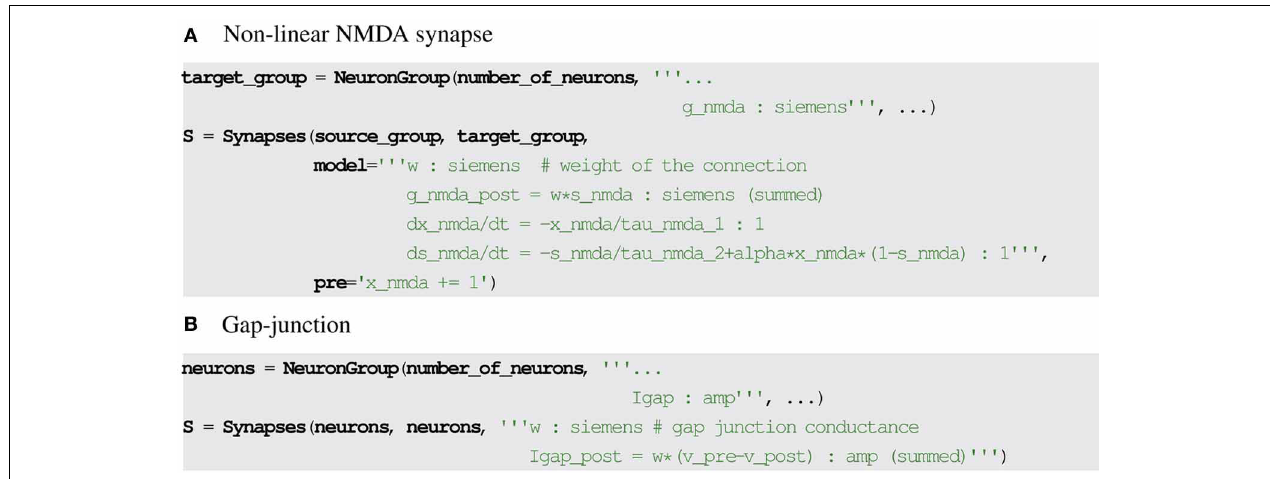
FIGURE 4 | Examples for synaptic model descriptions involving summed variables in Brian2. (A,B) The equation lines ending with (summed) specify that the post-synaptic variable indicated with the suffix _post is set by summing the corresponding synaptic values on each time